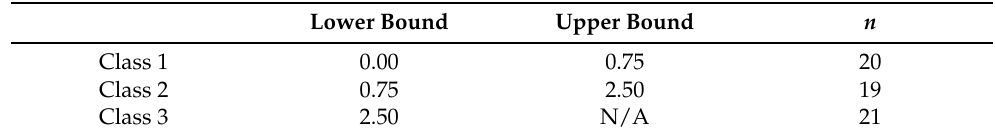
Table 4. SVM response